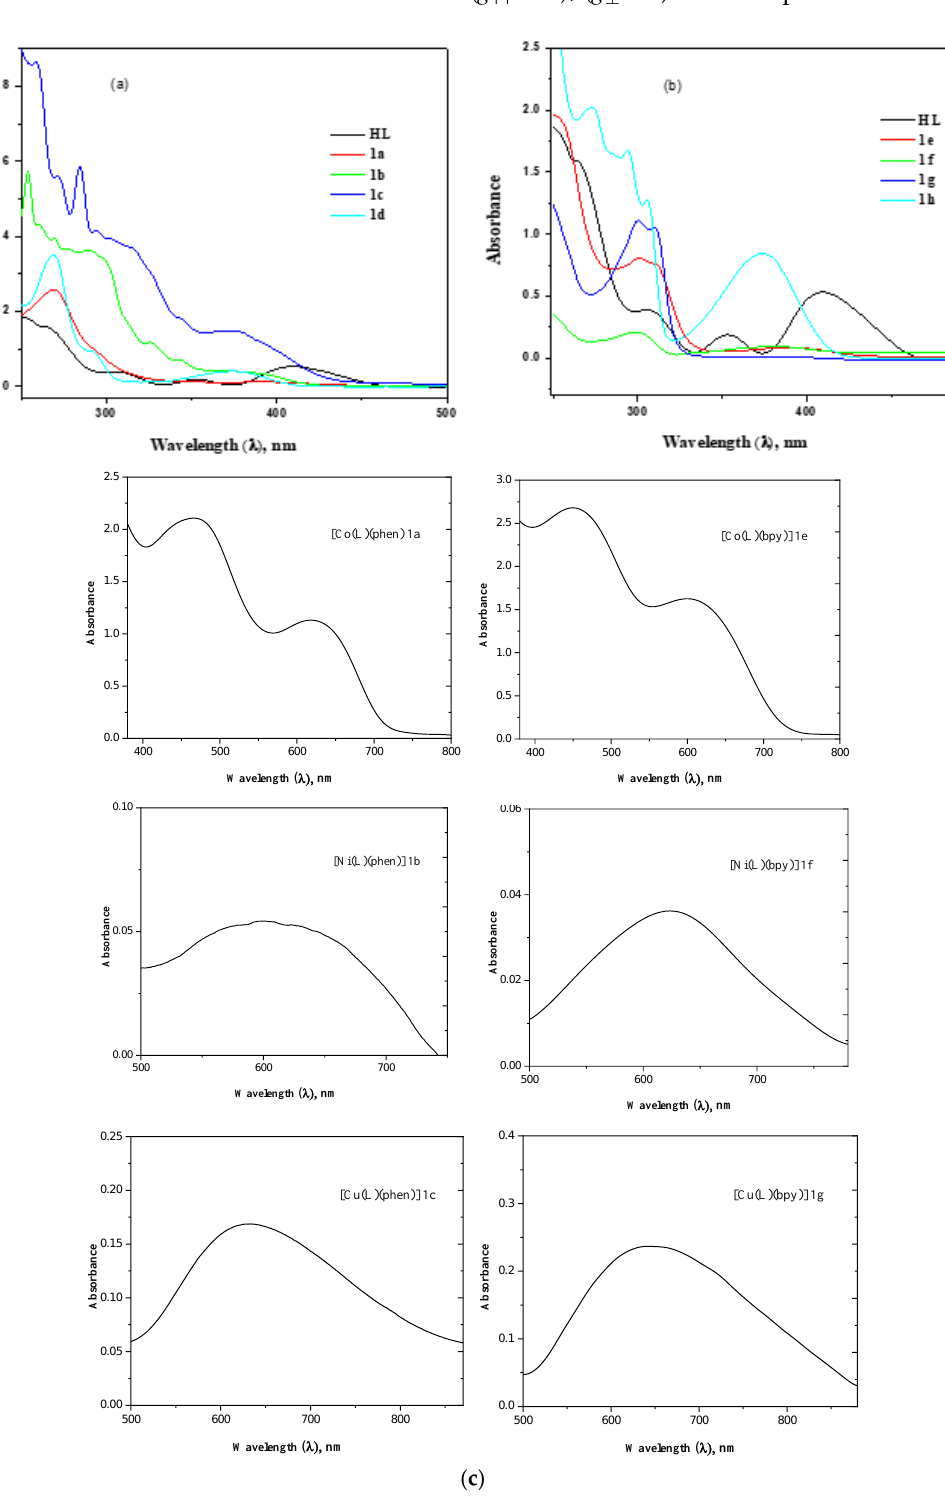
Figure 1. UV spectra of ( a ) complexes 1a – 1d and ( b ) complexes 1e – 1h and ( c ) visible spectra of complexes 1a – 1h in methanol.